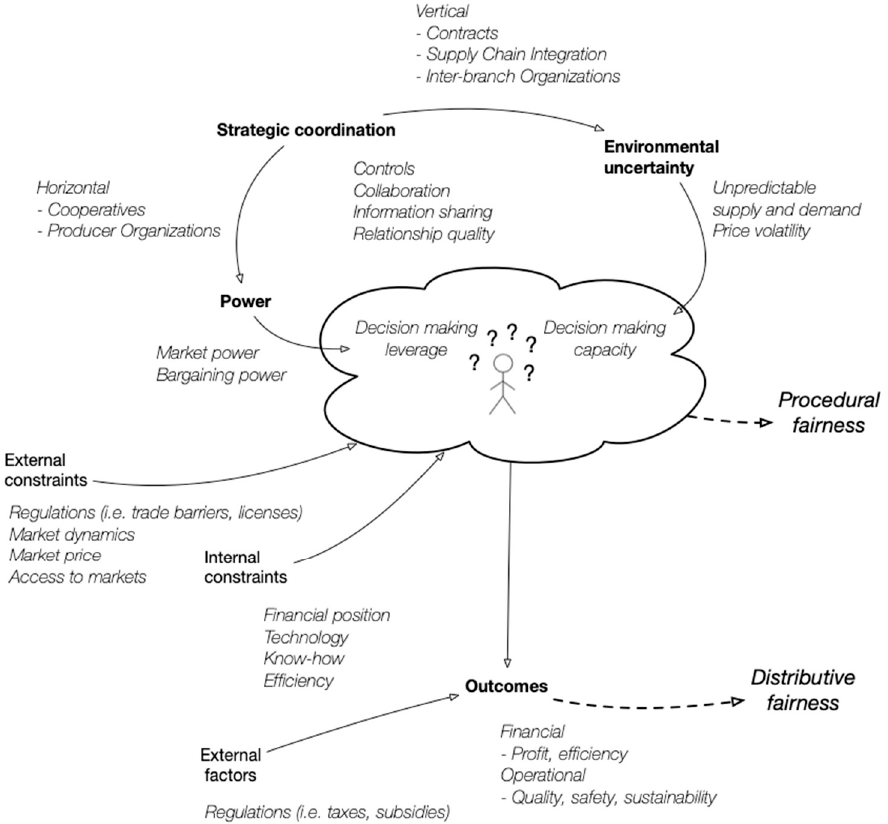
Figure 4. The factors related to IOF viewed in the context of organizational decision making. Perceptions of distributive fairness depend on outcomes and perceptions of procedural fairness depend on the influence individual actors have on their outcomes. Prominent factors impacting such perceptions are power dynamics, environmental uncertainty, and coordination strategies.